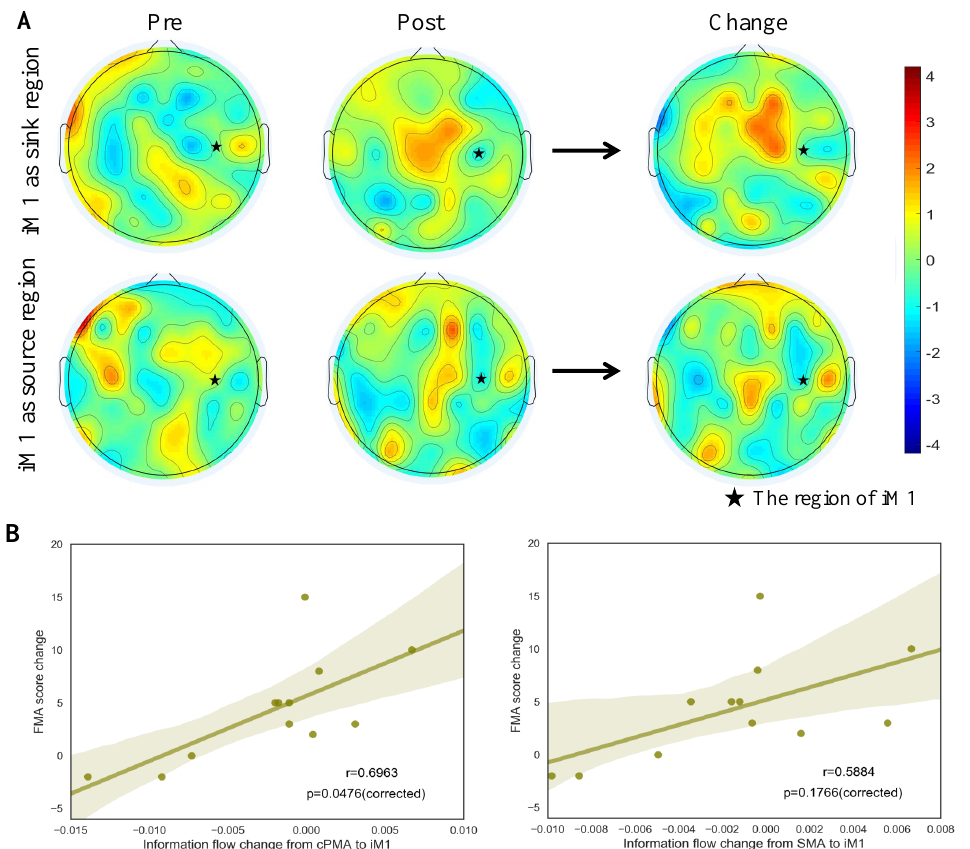
Figure 3. ( A ) The topography plots of information flow when iM1 set as sink/source regions. The first row represents the iM1 as sink region, where left and middle parts represent the condition of pre- and post-training, respectively. The right part is the change of information flow after training given iM1 as the sink region. The second row represents the iM1 as the source region, where left and middle parts represent the condition of pre- and post-training, respectively. All values were z-normalized across the whole brain for better visualization. ( B ) The correlation between FMA score changes and information flow change from cPMA to iM1 (left), SMA to iM1 (right).